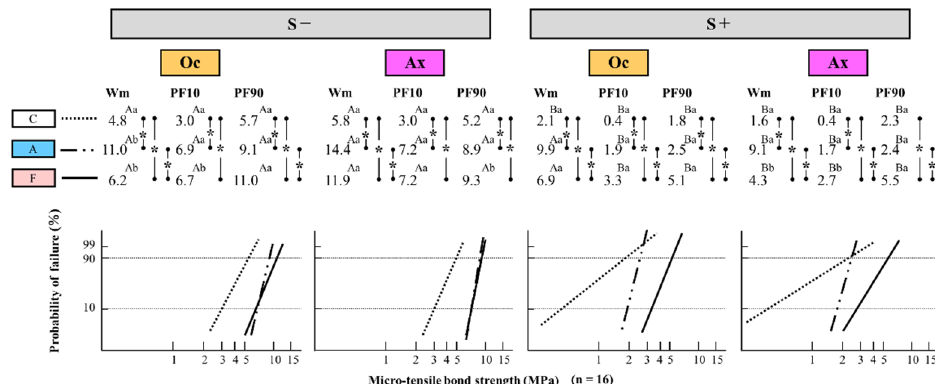
Figure 3. Differences in Weibull parameters for on the occlusal and axial walls among the three types of immediate dentin sealing with and without cyclic loading. Wm: Weibull modulus; PF10: Weibull stress (MPa) for a 10% failure probability; PF90: Weibull stress (MPa) for a 90% failure probability. The asterisks (*) among the three types of immediate dentin sealing indicate statistically significant differences at p < 0.05. Different uppercase letters between two conditions with and without cyclic loading in the same immediate dentin sealing and in the same abutment wall indicate statistically significant differences at p < 0.05. Different lowercase letters between two different abutment walls in the same immediate dentin sealing and in the same cyclic loading condition indicate statistically significant differences at p < 0.05. Table 3. Weibull parameter values of each experimental condition.